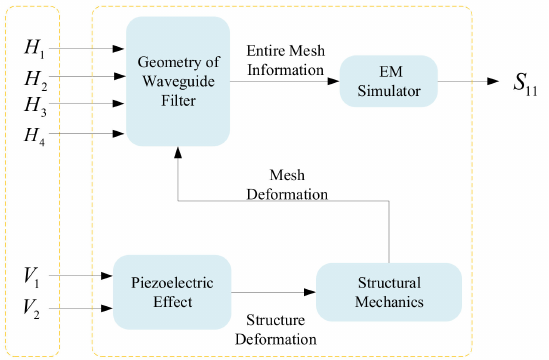
Figure 8. Actual process of COMSOL Multiphysics simulation for the three-pole waveguide